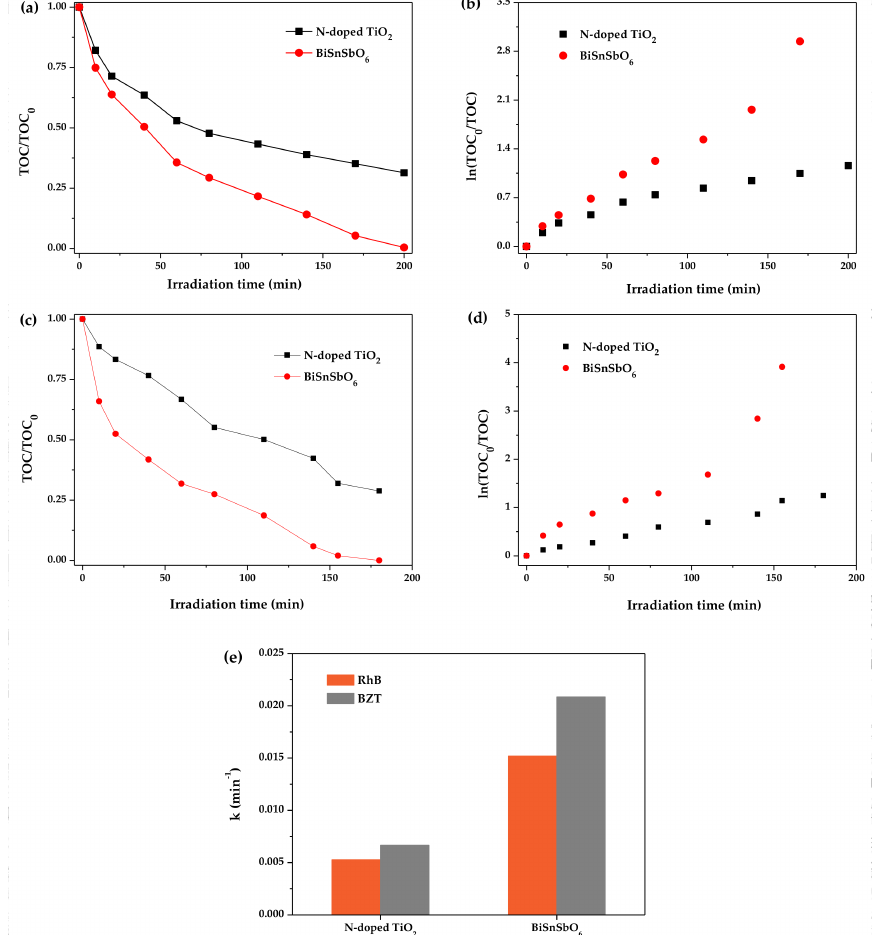
Figure 8. ( a ) Total organic carbon curves of RhB over different samples; ( b ) Linear plots of ln(TOC 0 /TOC) vs. reaction time; ( c ) Total organic carbon curves of BZT over different samples; ( d ) Linear plots of ln(TOC 0 /TOC) vs. reaction time; ( e ) The removal rate constants ( k ) of total organic carbon calculated from ( b , d